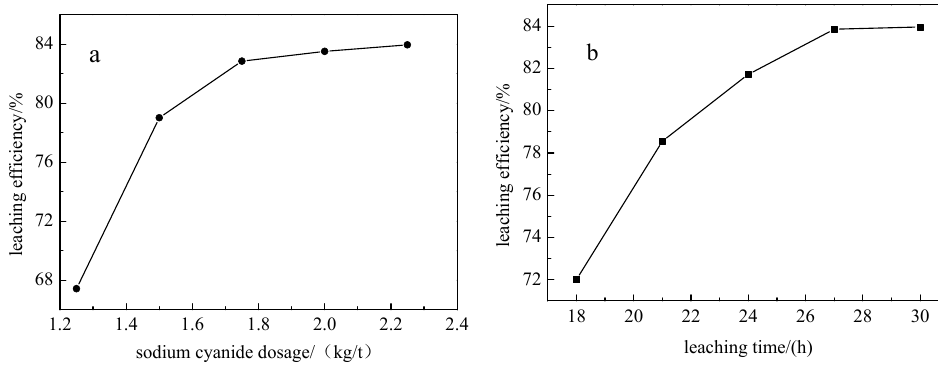
Figure 12. The effect of sodium cyanide dosage ( a ) and leaching time ( b ) on the leaching efficiency.